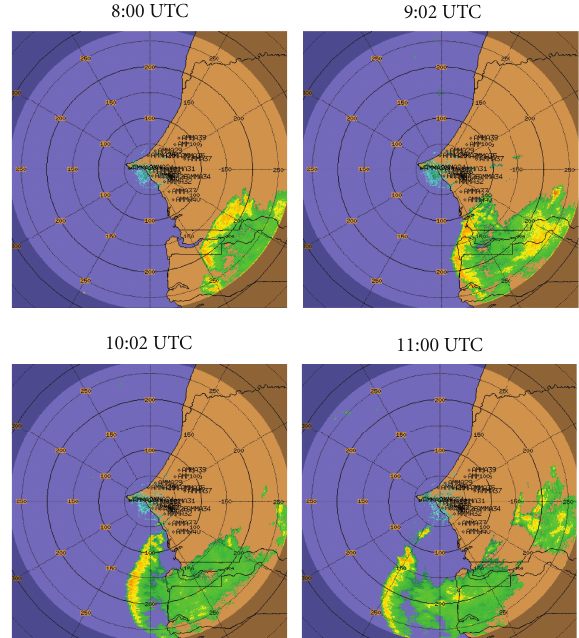
Figure 8: Surveillance scans of radar reflectivity (dBZ) time series for 0800 UTC, 0902 UTC, 1002 UTC, and1100 UTC on 11 September 2006. The black circles designate the 100, 150, 200, and 250 km radial distances from the NPOL radar.